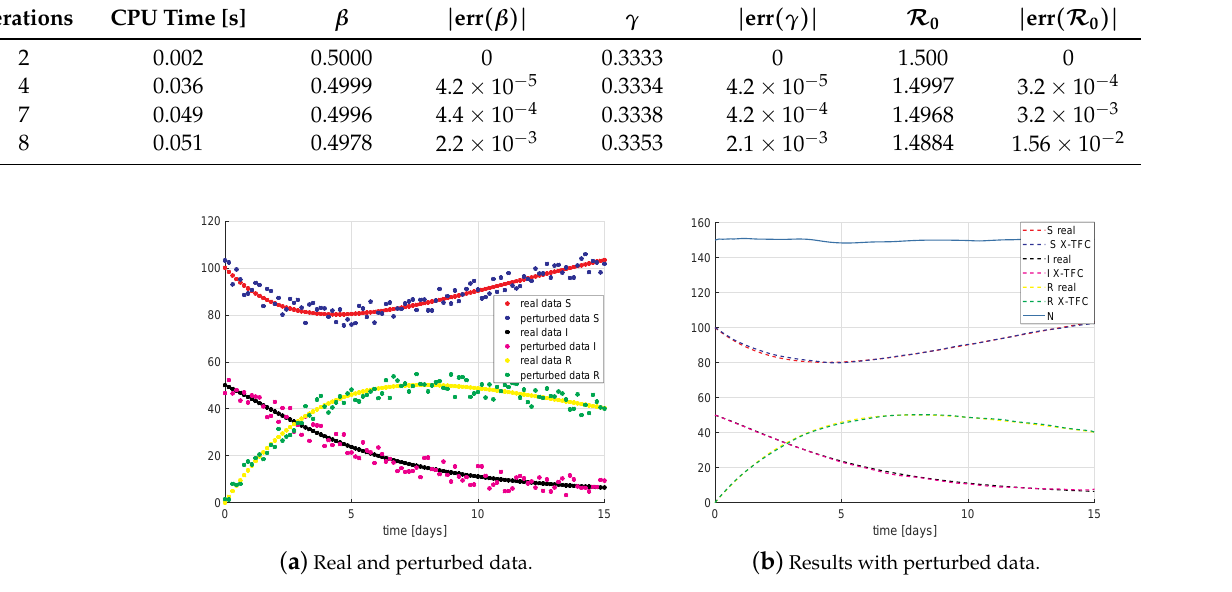
Figure 3. Results for SIR model with δ = 5, n = 100, and L =